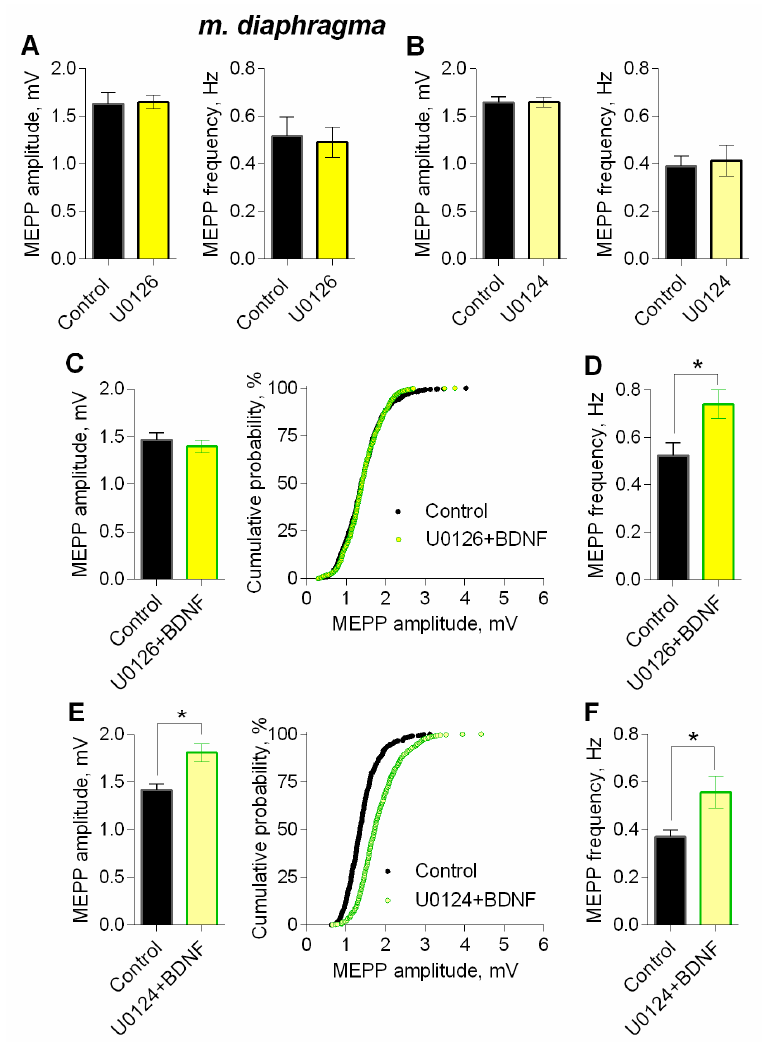
Figure 10. Intracellular signaling mechanisms underlying BDNF-induced upregulation of spontaneous neuromuscular transmission at the mouse diaphragm NMJs. MEK1 / 2 mediates BDNF-induced increase in MEPP amplitude. ( A ) Mean amplitude of MEPPs (left) and mean MEPP frequency (right) in control ( n = 16) and upon application of MEK1 / 2 inhibitor U0126 (20 µ M) ( n = 23). ( B ) Mean amplitude of MEPPs (left) and mean MEPP frequency (right) in control ( n = 20) and upon application of inactive analog of U0126 (U0124, 20 µ M) ( n = 22). ( C ) Mean amplitude of MEPPs (left) and cumulative probability plots (right) in control ( n = 24) and after BDNF was added in the presence of preapplied U0126 ( n = 27). ( D ) Mean frequency of MEPPs in control and upon application of BDNF in the presence of U0126. ( E ) Mean amplitude of MEPPs (left) and cumulative probability plots (right) in control ( n = 15) and after BDNF was added in the presence of preapplied U0124 ( n = 17). (F) Mean frequency of MEPPs in control and upon application of BDNF in the presence of U0124. Histograms and error bars represent the mean ± SEM. * p < 0.05 compared to control .